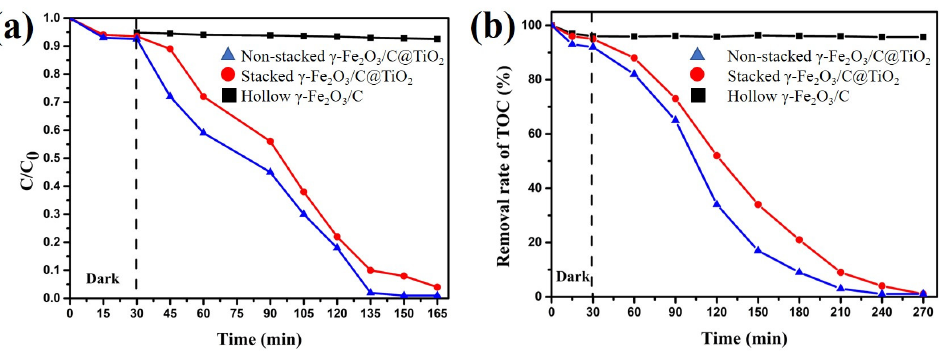
Figure 8. Conversion ( a ) degradation of phenol and (TOC) ( b ) total organic carbon over non-stacked